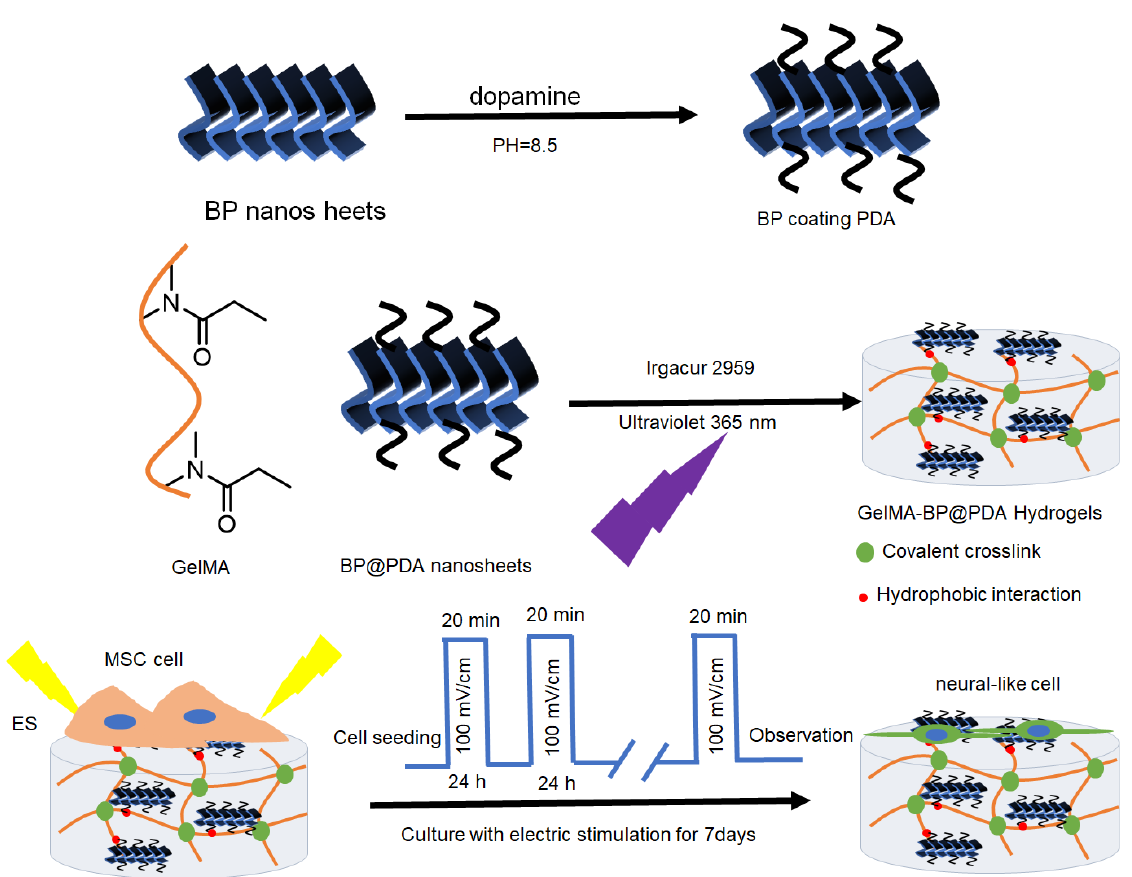
Figure 19. Schematics of GelMA-BP@PDA hydrogels. The surface modification of BP nanosheets by PDA. Incorporation of the PDA-BP (BP@PDA) nanosheets into a GelMA network. Schematic of regulating the growth and differentiation of MSCs by conductive GelMA-BP@PDA hydrogel under external electrical stimulation [89].